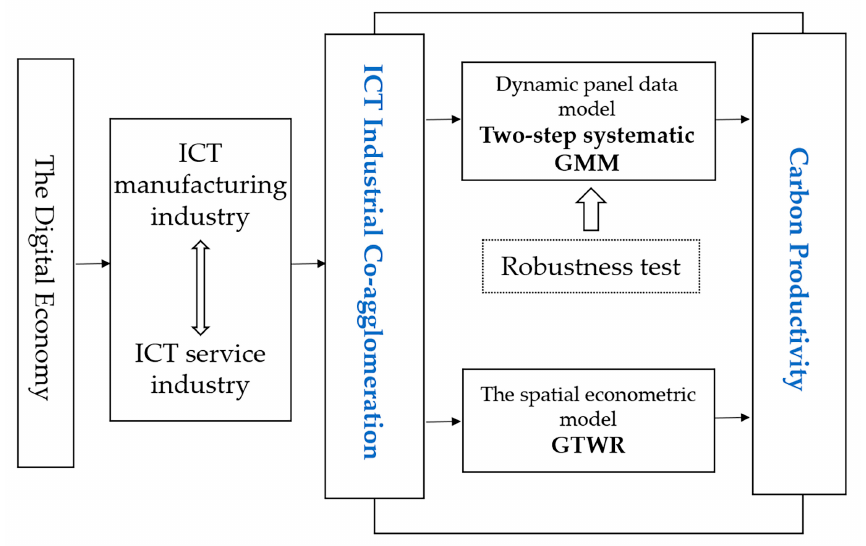
Figure 1. Research Framework.